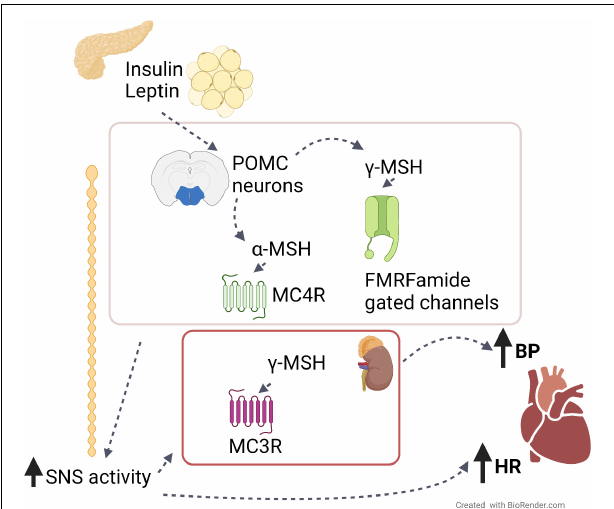
FIGURE 1 | The role of the melanocortin system on BP and HR. Leptin from adipose tissue and insulin from the pancreas induce the production from hypothalamic POMC neurons of melanocortin peptides, such as α - and γ -MSH. By binding their receptors, MC4R and FMRFamide gated ion channels, respectively, these peptides induce the activation of the sympathetic nervous system, which in turn increases blood pressure (BP) and heart rate (HR). The same effects are also caused peripherally by γ -MSH via its binding to receptor MC3R in the